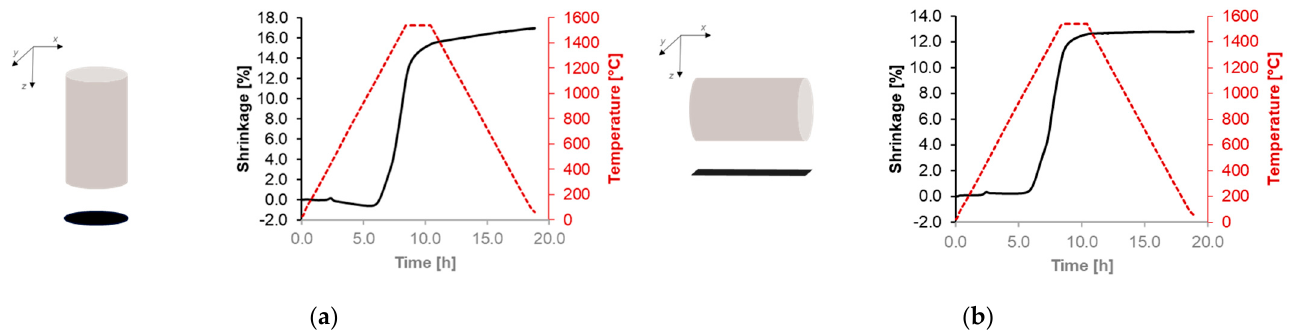
Figure 11. ( a ) Dilatometry of the vertically printed sample. ( b ) Dilatometry of the horizontally printed sample.